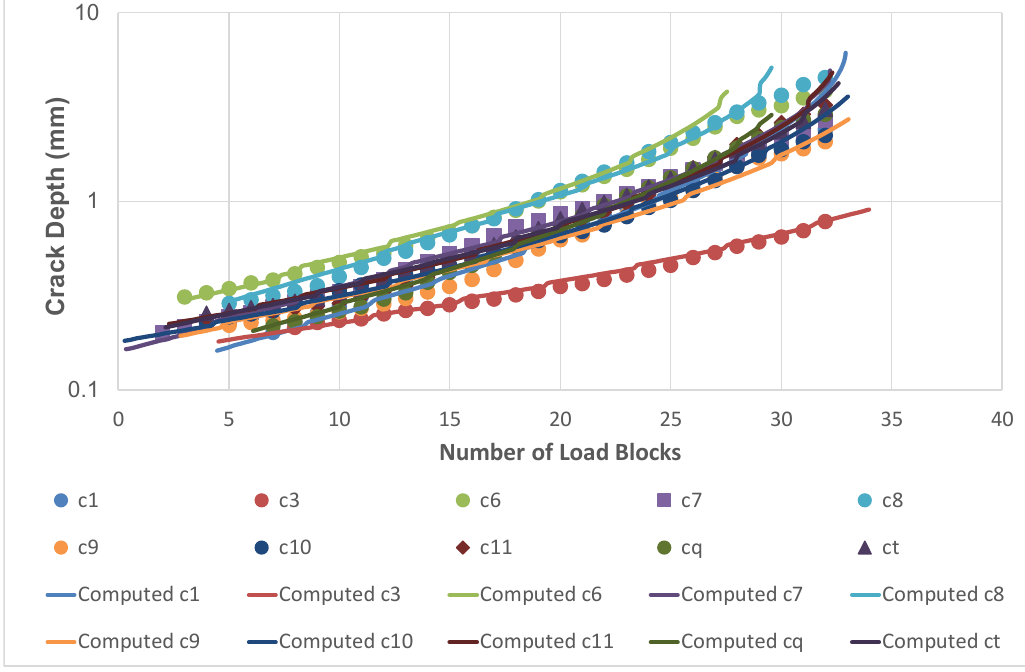
Figure 27. Comparison between the measured and computed crack growth histories for Specimen 2.